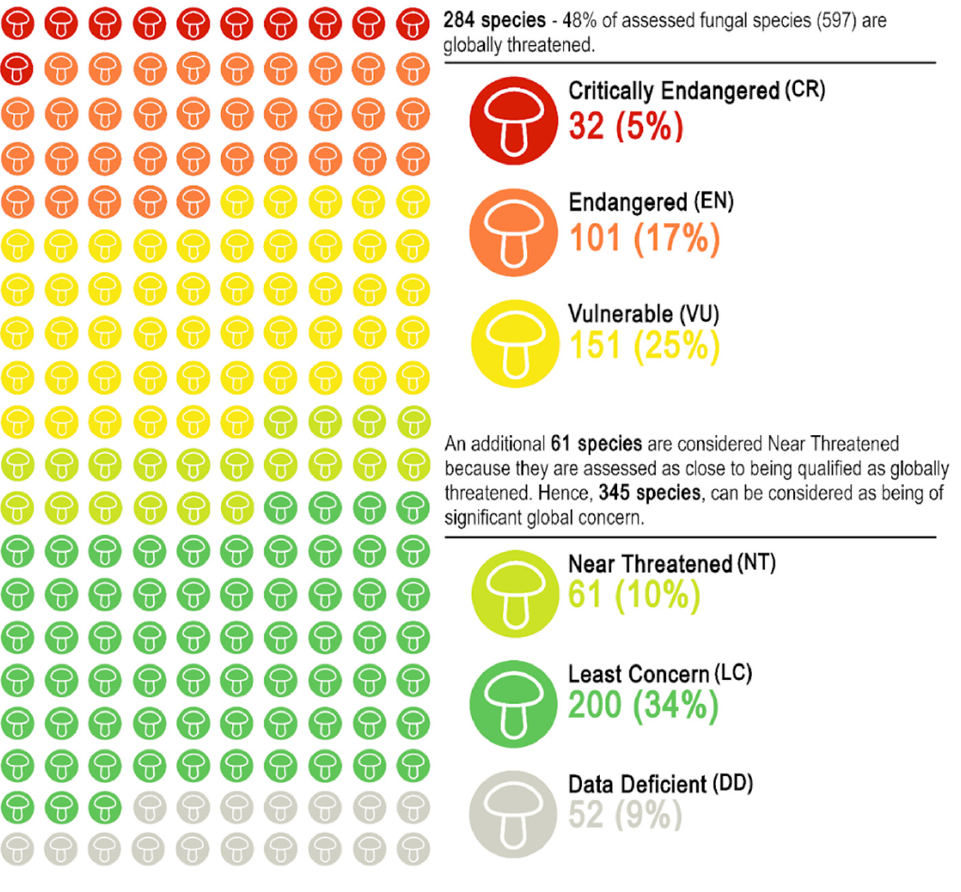
Figure 3. Number of species at different Red List categories for the 597 fungi currently globally assessed on the IUCN Red List (July 2022). Refer to the text for bias on species selection and why the proportion of Red List categories is not globally representative of fungi in general.